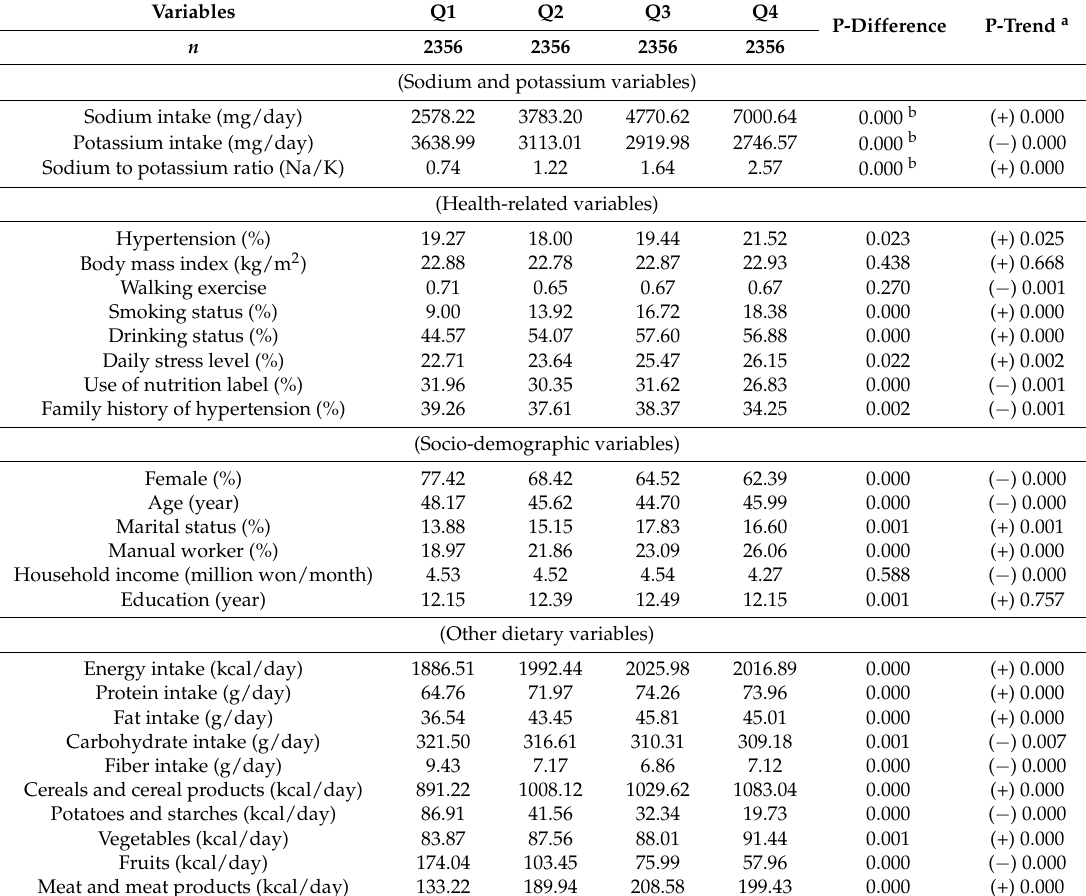
Table 2. Summary statistics of the study population divided into quartiles of the sodium to potassium